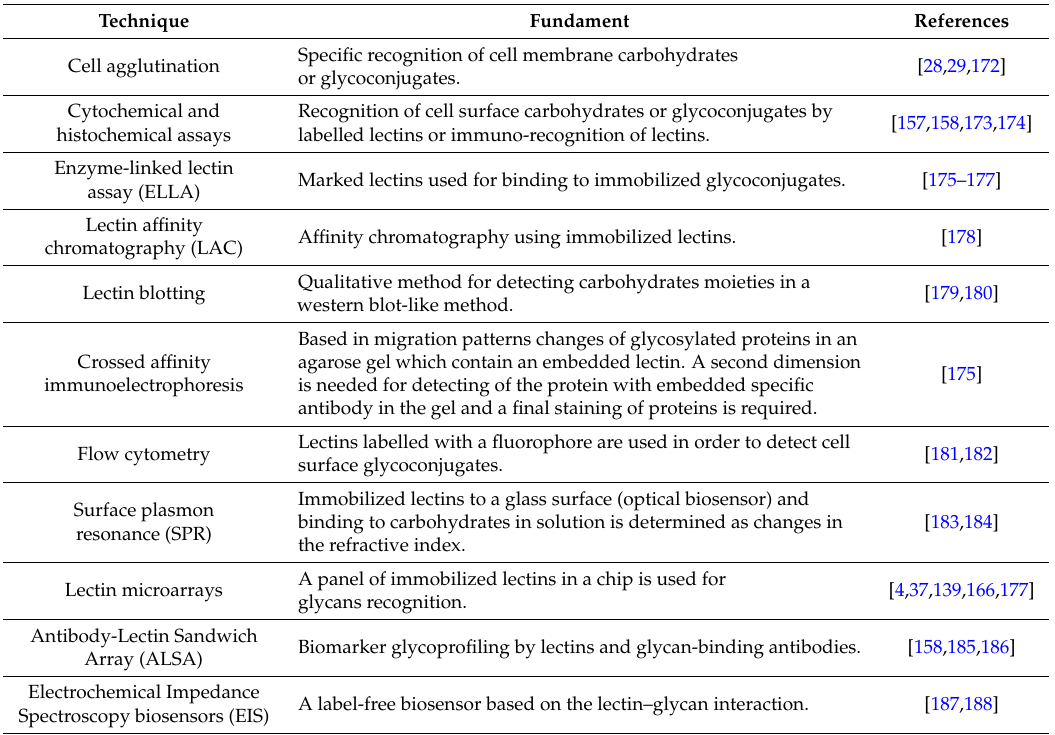
Table 2. Lectin-based analytical techniques for glycan detection (modified from [171]).